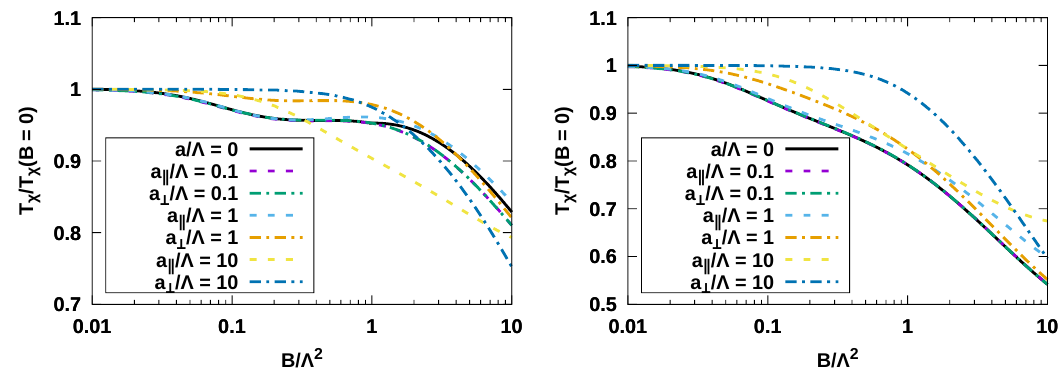
Figure 3 . Chiral transition temperature for c = 0 . 4 (left panel) and c = 0 . 25 (right panel) as a function of the magnetic field for various values of the anisotropic parameter and for different orientation choices as indicated in the